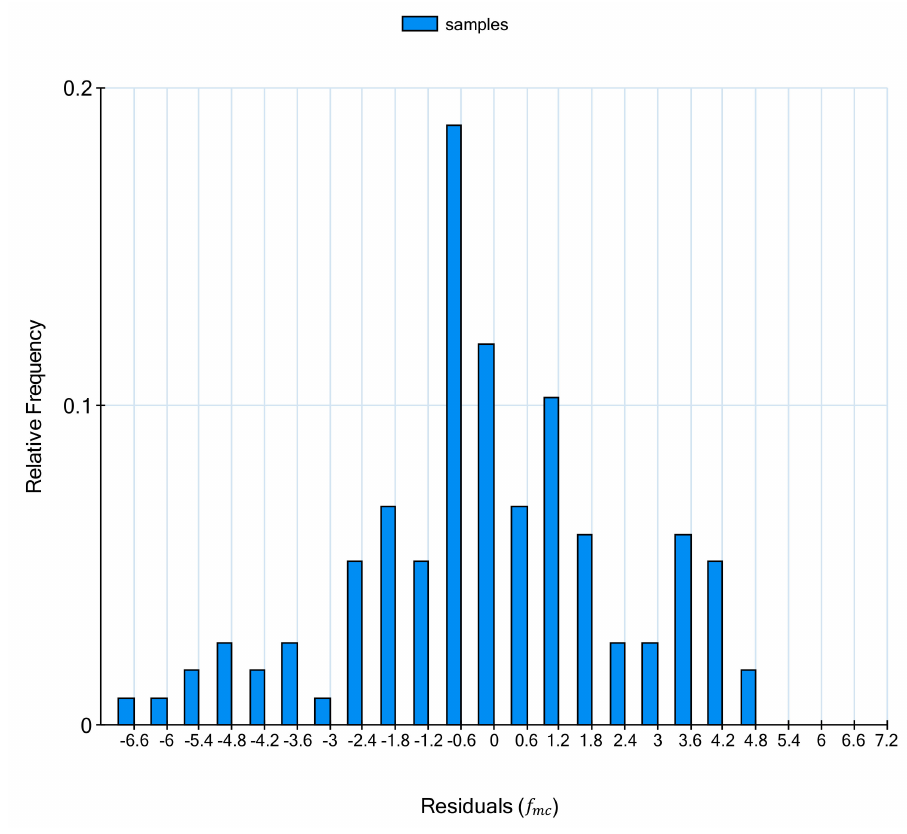
Figure 11. Relative frequency histogram of residuals error of simple symbolic